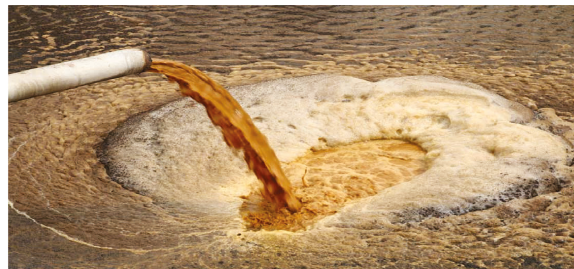
Figure 1: Palm oil mill effluent (POME) [24]. Table 2: Characteristics of palm oil mill effluent (POME) [8]. Parameter Concentration